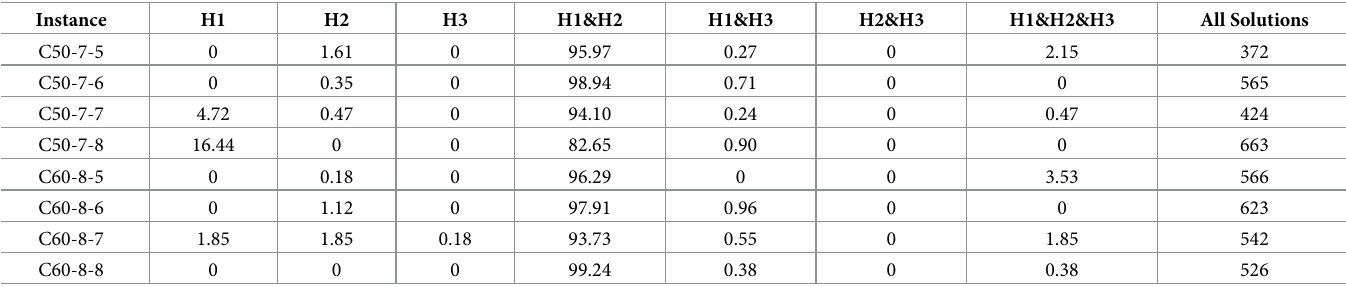
Table 9. Analysis on the number of solutions with different fleet compositions (a special